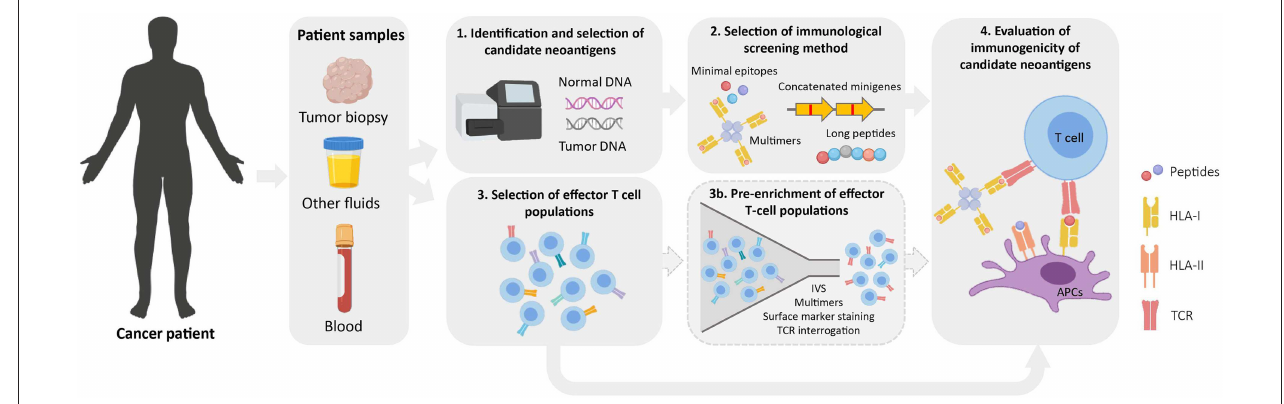
FIGURE 2 | Workflow for the identification of immunogenic neoantigens. Normal and tumor DNA obtained from cancer patients are used to identify tumor-specific NSM by WES (1). Upon selection of candidate neoantigens (see Figure 1 ), different immunological screening methods can be used to evaluate peptide immunogenicity (2). Prior to evaluating their immunogenicity, effector T-cell populations of interest are selected from cancer patient samples (3). These can either be directly used in immunological screening assays or as a starting source for an optional pre-enrichment step to increase the frequency of neoantigen-specific T